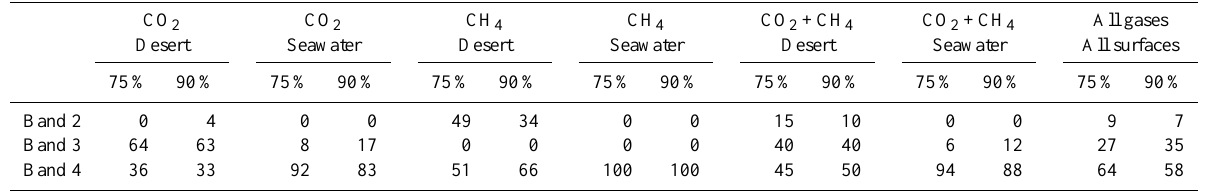
Table 4. Band-by-band distribution (in %) of the selected channels in Case 2.